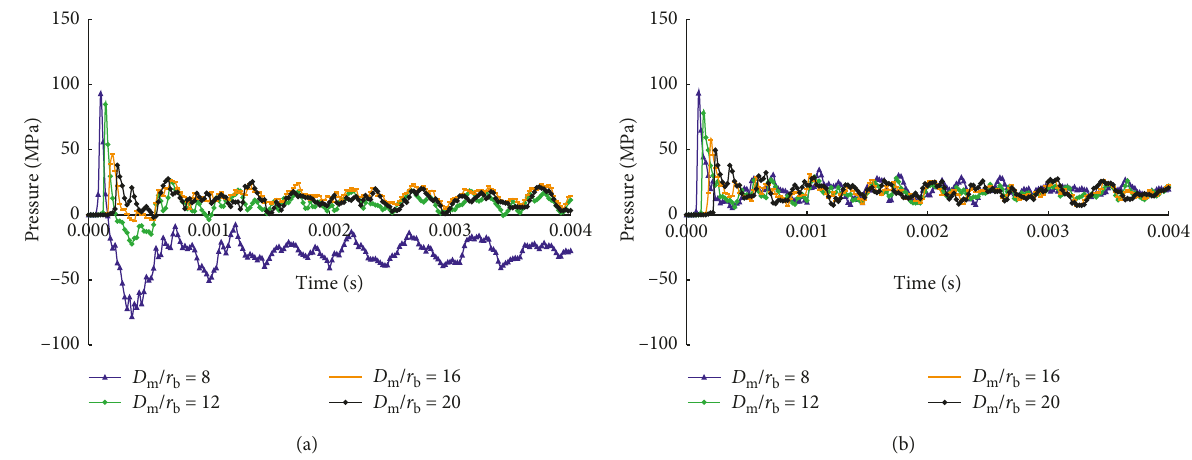
Figure 15: P-T curve of different monitoring points of #3 simulation case: (a) α